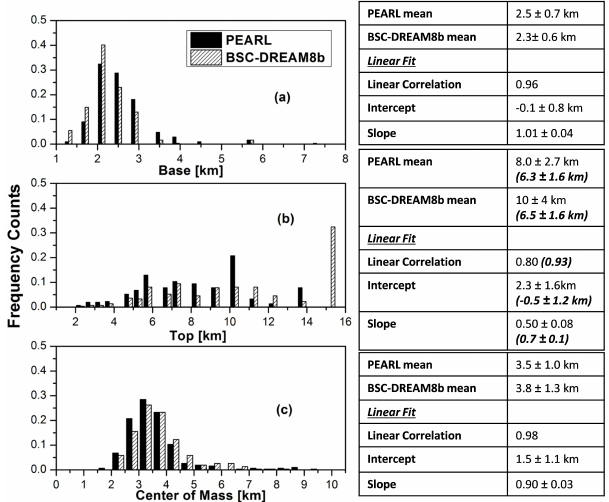
Figure 1. Distribution of the dust layer base (a) , top (b) and center of mass (c) as measured by the PEARL lidar and modeled by BSC-